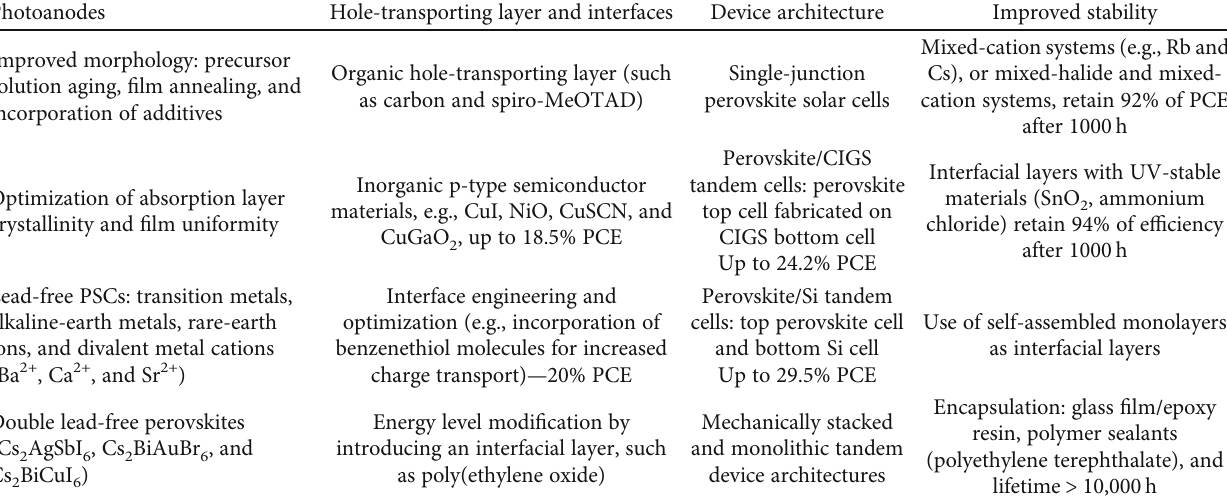
Table 3: State-of-the-art materials, processes, and methods used for the development of PSCs.